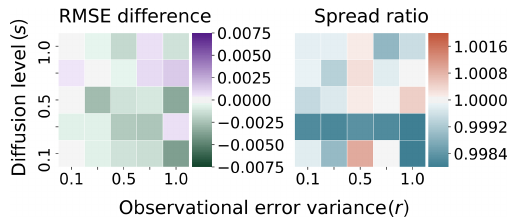
Figure 6. Truth: Taylor (cid:49) t = 10 − 3 . Ensemble: Runge–Kutta (cid:49) e = 10 − 2 . Difference in RMSE/ratio spread with benchmark Fig. 5.